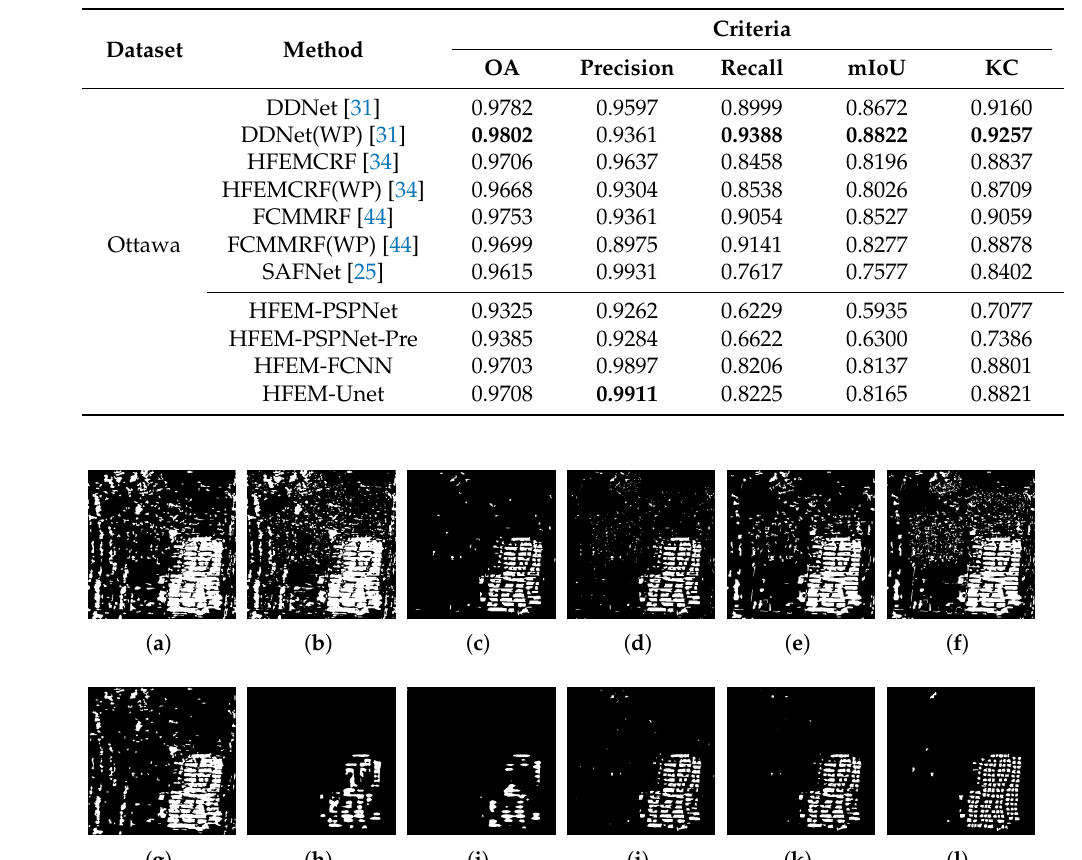
Table 3. The numerical results of Ottawa dataset.